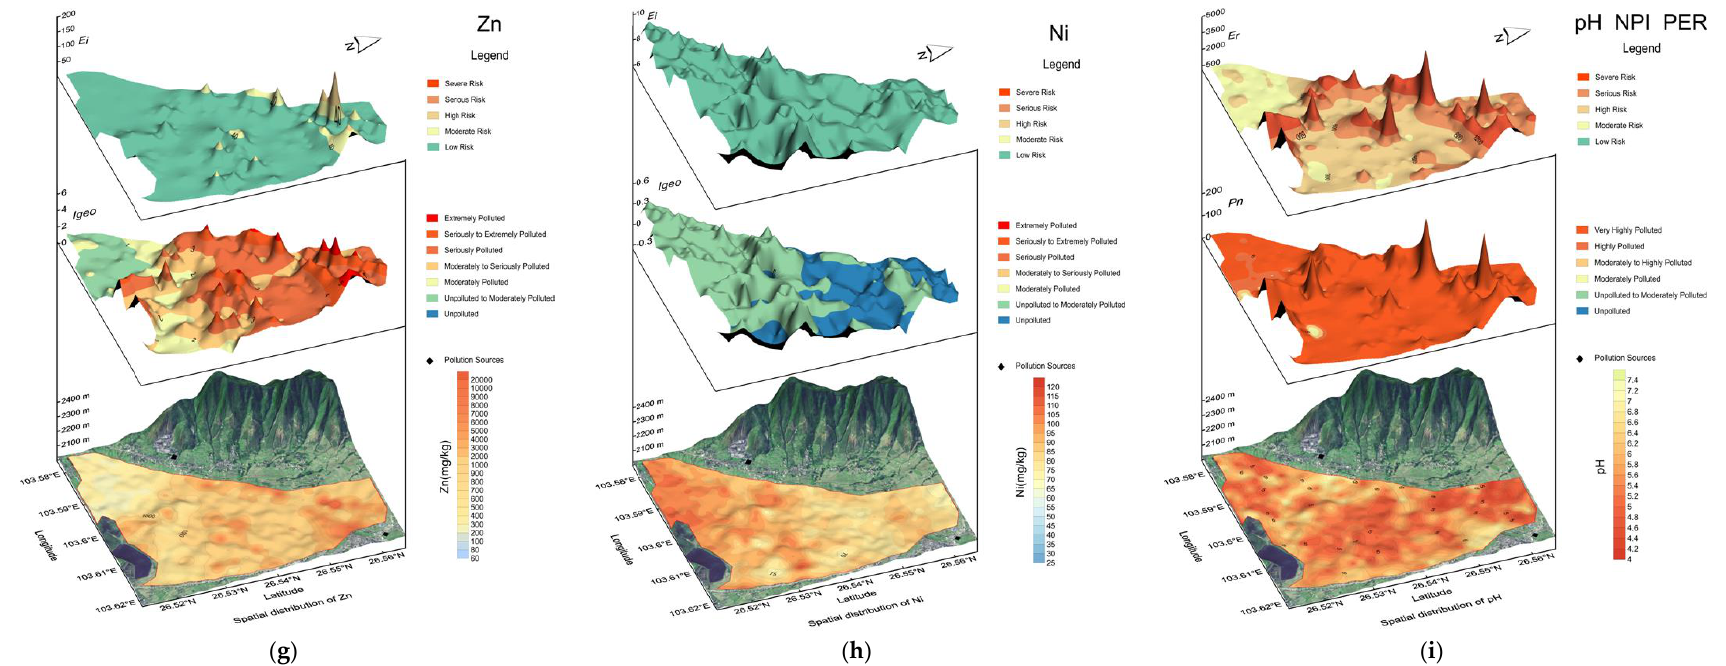
Figure 3. Spatial distribution maps of metal concentration and tridimensional heat maps of Igeo index and E i index of Cd ( a ), As ( b ), Hg ( c ), Pb ( d ), Cr ( e ), Cu ( f ), Zn ( g ), Ni ( h ) and spatial distribution maps of pH and tridimensional heat maps of P n and E r index ( i ).